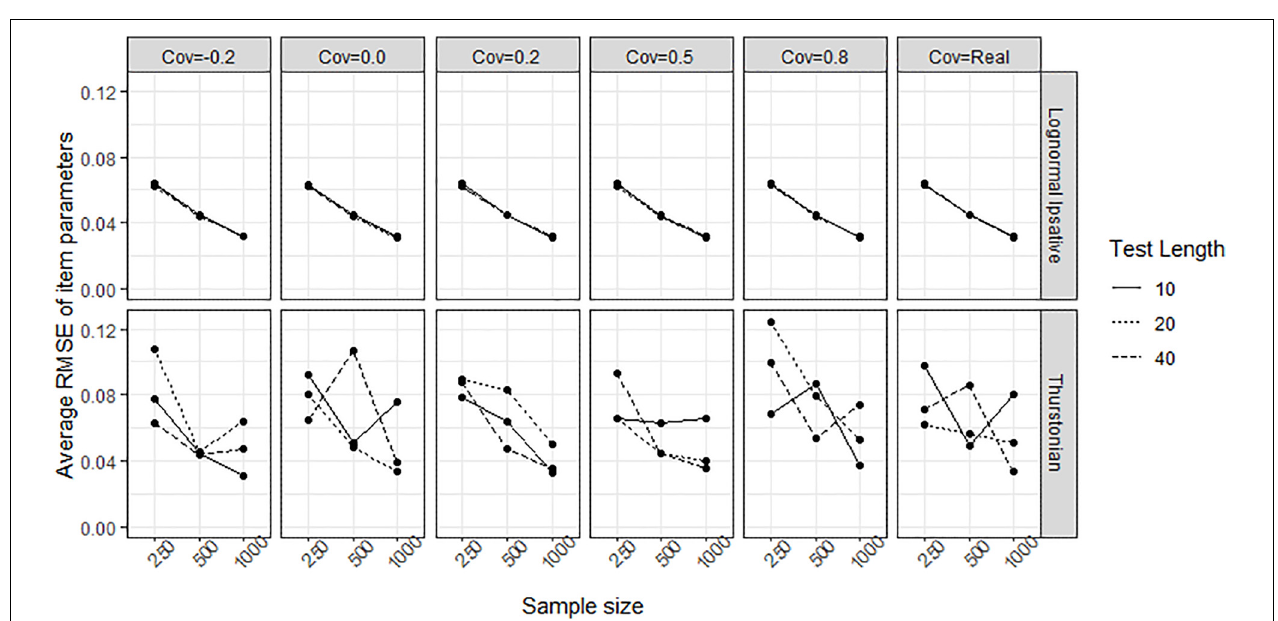
FIGURE 8 | Average bias of item parameters obtained by fitting the LIM and the Thurstonian model to simulated data. The types of lines indicate the test lengths. Cov = the covariance between latent trait. Cov = Real indicates the variance-covariance matrix followed the empirical result in literature.